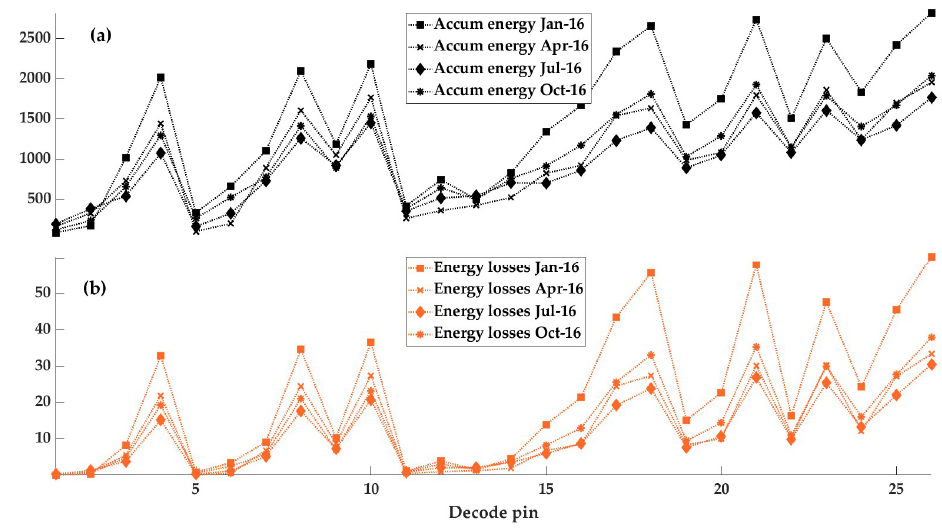
Figure 10. Accumulated energy and losses in 2016 (MWh)—seasonal comparison. ( a ) Accumulated energy for 4 months representing the seasons of 2016; ( b ) Energy losses for 4 months representing the seasons of 2016.